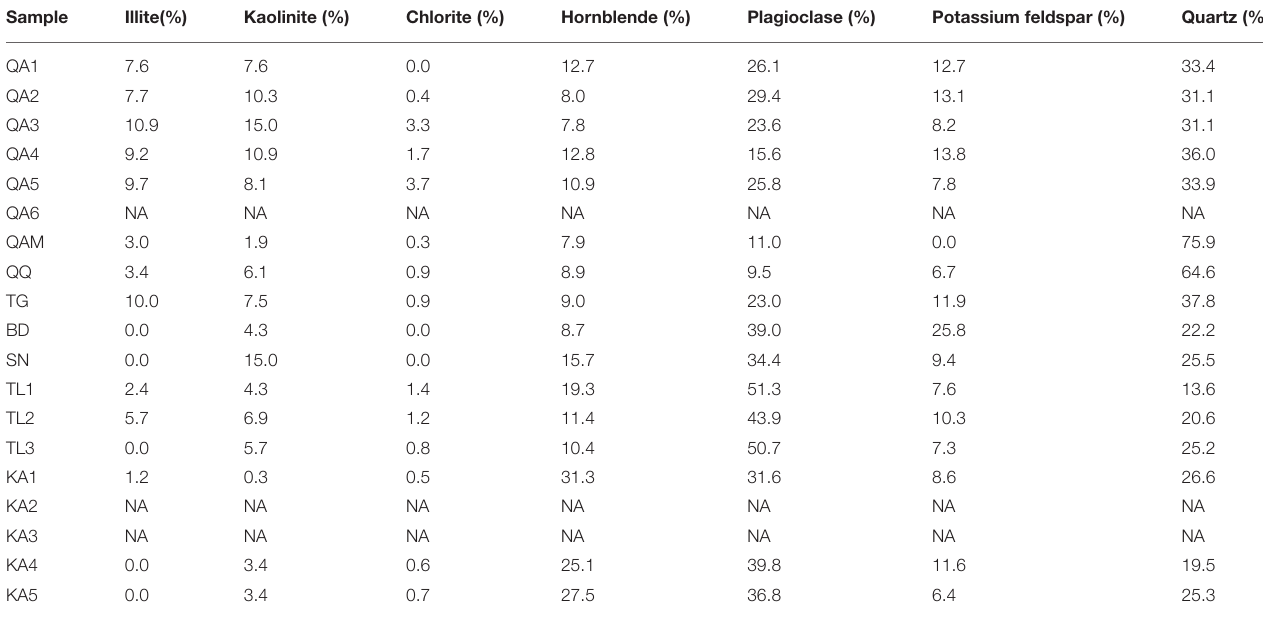
TABLE 4 | Mineral proportions in cryoconite and moraine on and around the glaciers in northwestern and southwestern Greenland. Sample